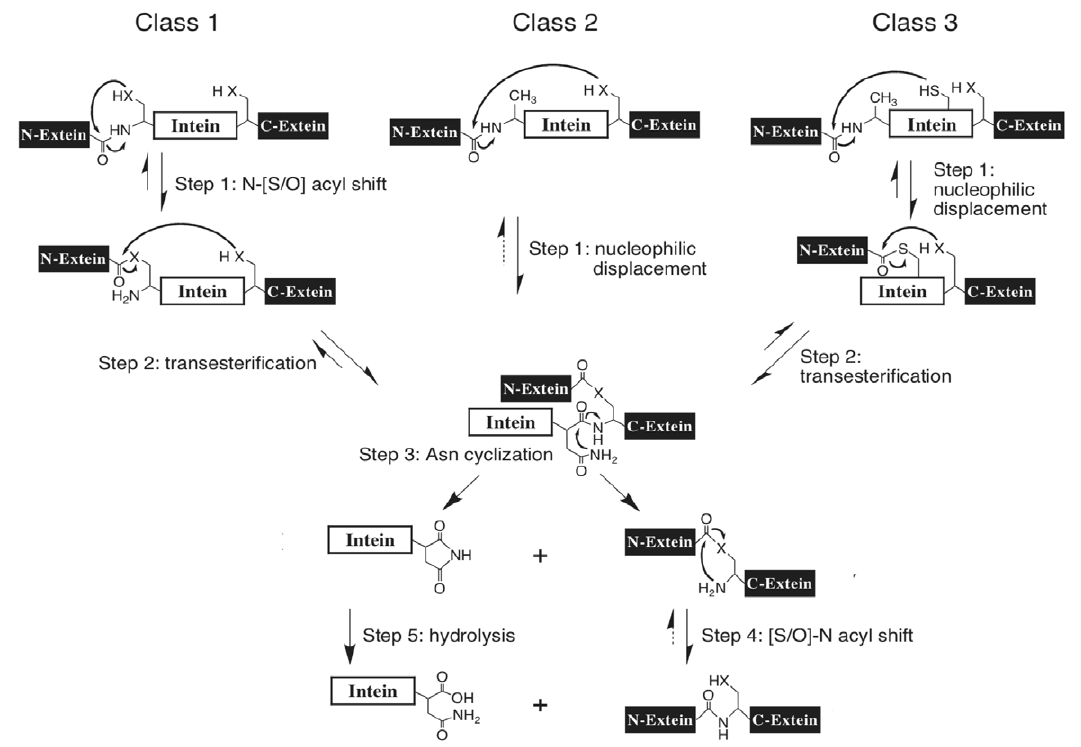
Figure 2. Splicing mechanisms for the three classes of inteins. The Class 1 intein-mediated protein splicing mechanism consists of four coordinated nucleophilic displacement reactions. Class 2 and Class 3 inteins form the same branched intermediate present in Class 1 inteins, but do so by different pathways because they generally start with amino acids incapable of forming the linear (thio)ester intermediate. Once this branched intermediate is formed, the remainder of the splicing reaction is the same in all inteins. Class 3 inteins also form a class specific Motif F branched intermediate with Cys at position F:4 as the branch point. Residues within the intein assist these enzymatic reactions. However, in all classes there is variability in the residues and positions within the intein that facilitate each reaction. Tetrahedral intermediates are not shown. ‘X’ represents the sulfur or oxygen atom in the side chain of Ser, Thr or Cys. Solid arrows represent steps that have been experimentally verified.